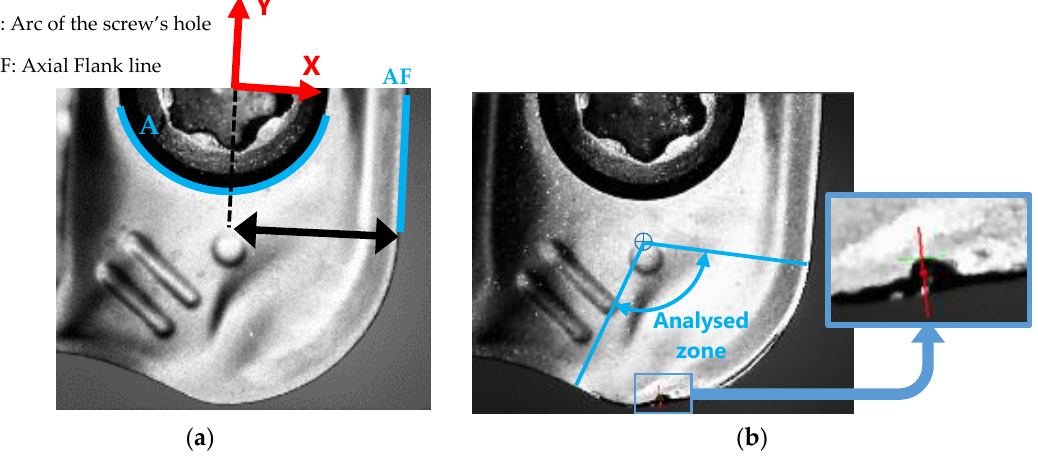
Figure 13. ( a ) References to rake face images. ( b ) Zone of tool wear measurement.